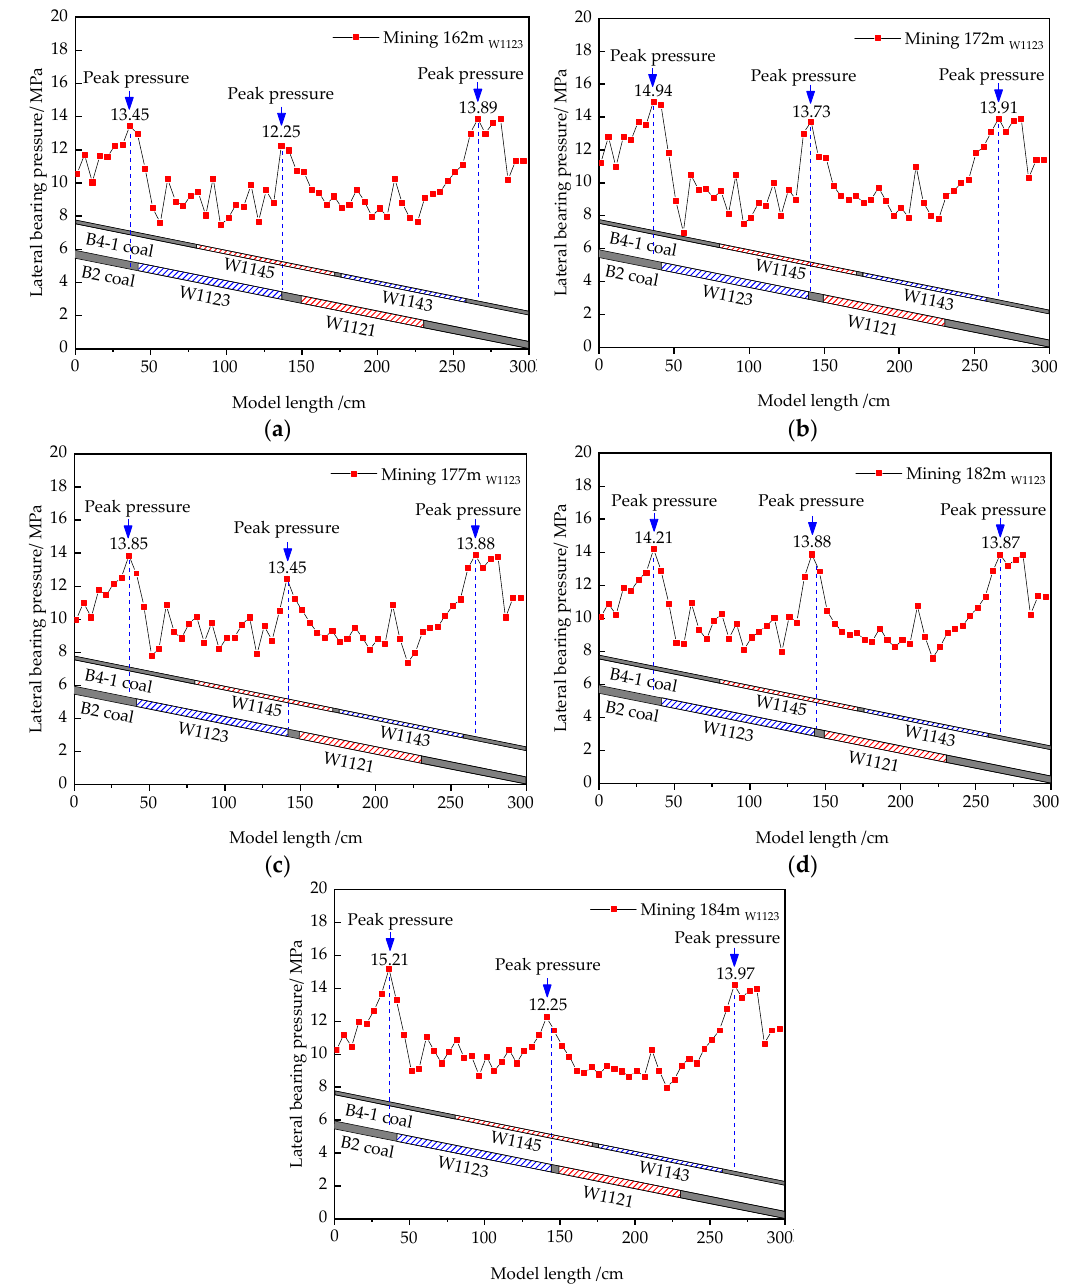
Figure 11. Stress distribution in working face with different width. ( a ) Mining 162 m; ( b ) mining 172 m; ( c ) mining 177 m; ( d ) mining 182 m; ( e ) mining 184 m.